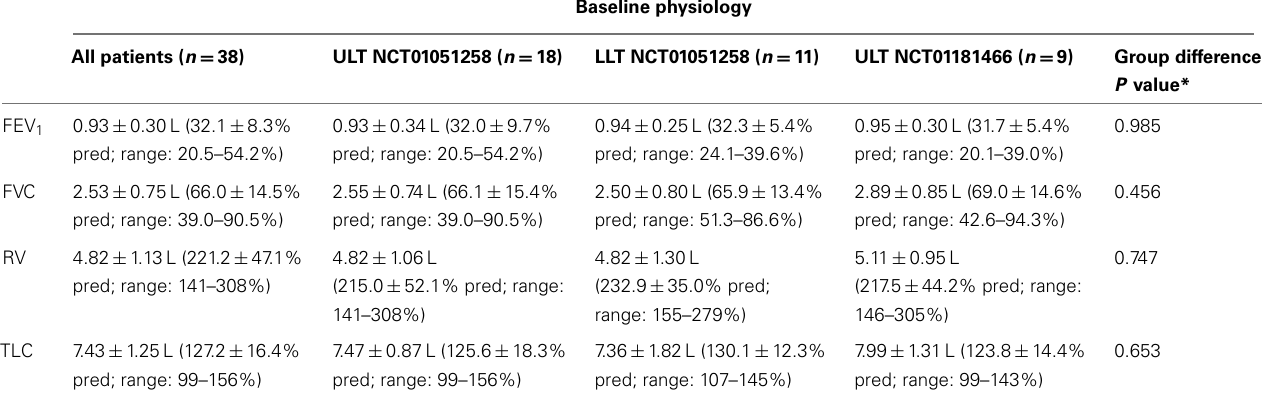
Table 2 | Baseline patient